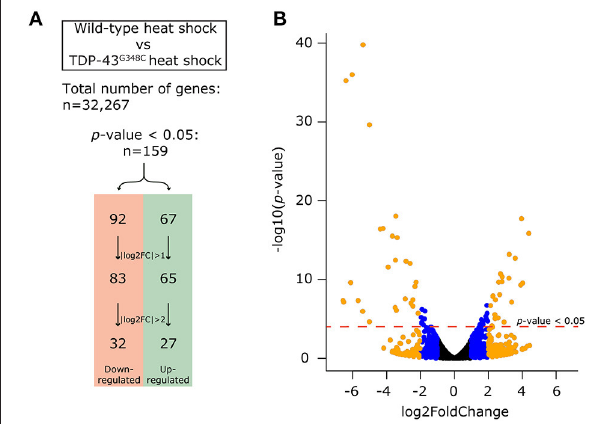
FIGURE 4 | Differential expression analysis obtained by RNA-sequencing. (A) In order to compensate for the effect of the heat shock, we compared the expression of genes between the wild-type heat shock and the TDP-43 G348C heat shock conditions. Out of the 32,267 genes identified, 159 genes (67 up-regulated and 92 down-regulated) had a significant differential expression ( p -value < 0.05). This number could be reduced by using a more stringent cut-off of either a |log2FC| > 1 (148 genes, 65 up-regulated and 83 down-regulated) or |log2FC| > 2 (59 genes, 27 up-regulated and 32 down-regulated). (B) Volcano plot showing all of the 32,267 genes. The dotted red line indicates the level of significance with p -value < 0.05. The blue dots show the genes with a |log2FC| comprised between 1 and 2. The orange dots show the genes with |log2FC| > 2.